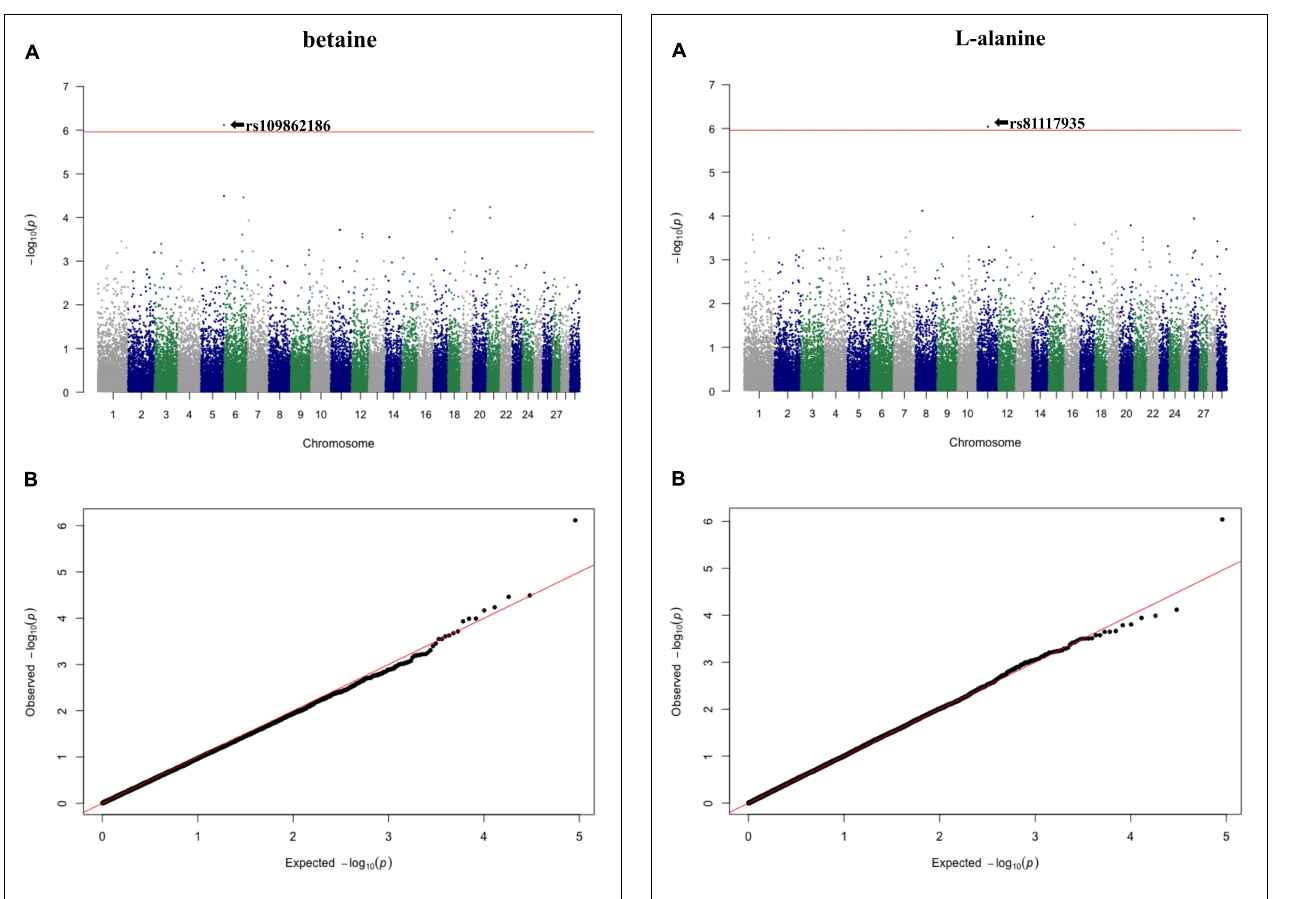
FIGURE 2 | Manhattan plot (A) and QQ plot (B) for betaine, significant SNPs were determined by Bonferroni correction (red line).